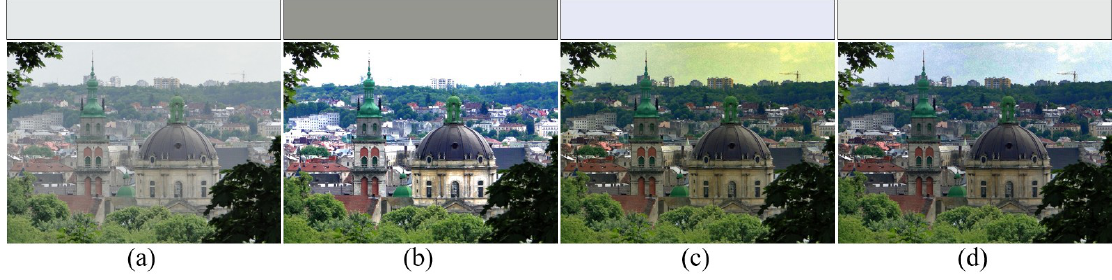
Figure 3. Comparative results of the atmospheric light estimation to remove haze. The top row shows the estimated atmospheric light using existing and proposed methods. The second row shows dehazed images using (3) and estimated atmospheric light of the top row: ( a ) input haze image [16], reproduced with permission from [16], IEEE, 1969 ( b ) Sulami’s method [11], ( c ) Berman’s method [15], and ( d ) the proposed